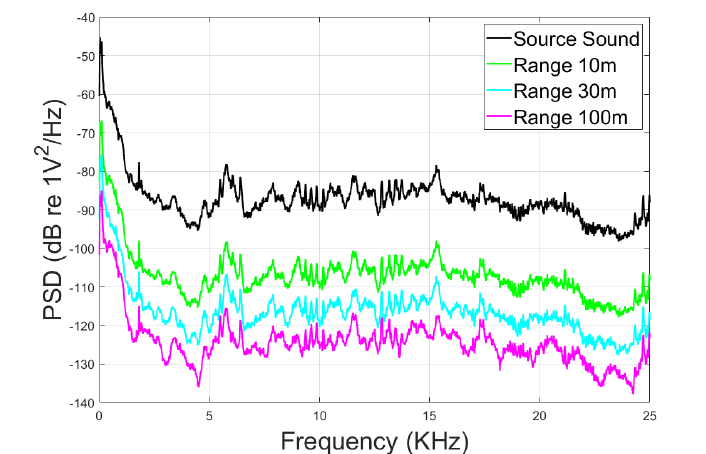
Figure 7. PSD of source sound and observed signals at the range of 10 m, 30 m, 100 m.